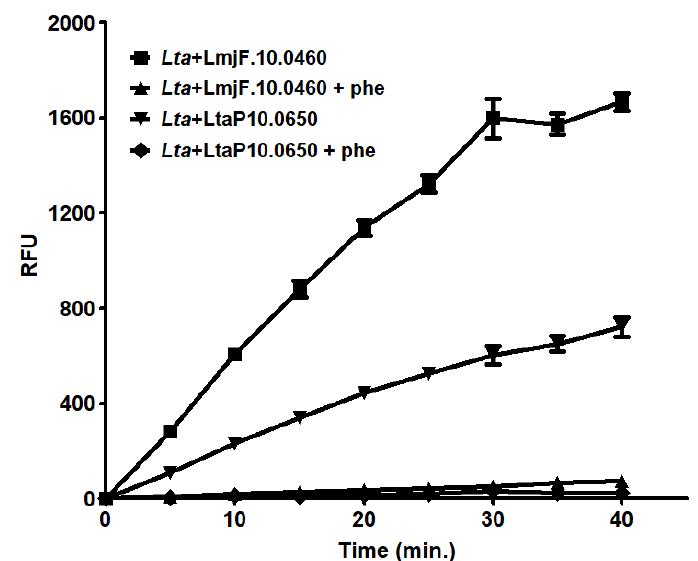
Figure 5. In solution proteolytic activity of overexpressed L. major LmjF.10.0460 and L. tarentolae LtaP10.0650 mutants. The enzymatic activity was assessed by measuring the hydrolysis of the flu- orogenic substrate MCA-Pro-Cha-Gly-Nva-His-Ala-Dpa-NH2 at 37 °C for 40 min. Activity of the cloned leishmanolysin from L. tarentolae ( Lta + LtaP10.0650 ) and from L. major ( Lta + LmjF.10.0460 ) were measured in 100 mM glycine-NaOH buffer pH 10.0 buffer the presence or absence of 1 µM1,10- phenantroline ( Lta + LtaP10.0650 + phe and Lta + LmjF.10.0460 + phe). Results are expressed as rela- tive fluorescence units (RFU) and the values represent the mean ± standard deviation of three inde- pendent experiments performed in triplicate. Table 2. Effects of inhibitors on the proteolytic activity of overexpressed Leishmania tarentolae leish- manolysins.